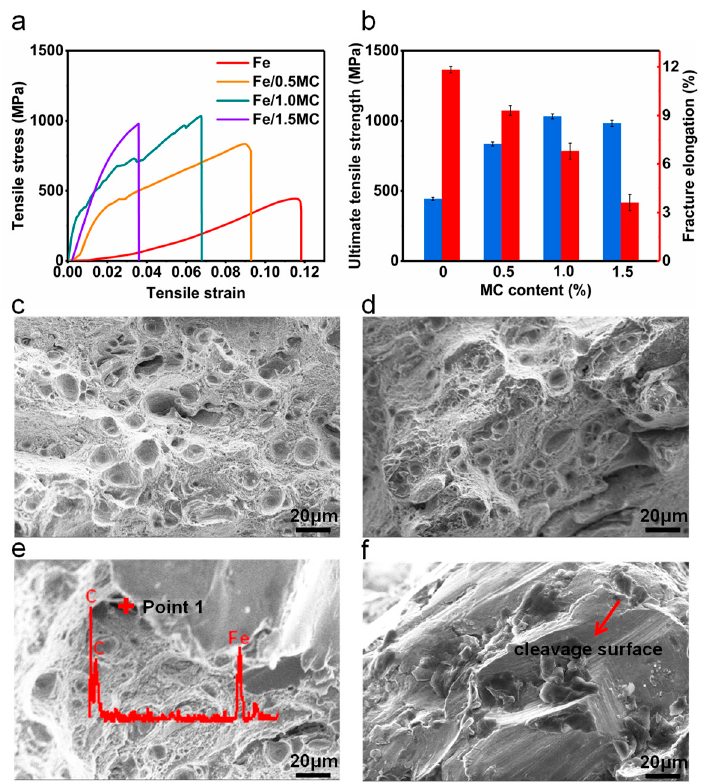
Figure 4. ( a ) Representative stress–strain curves obtained from tensile tests; ( b ) The calculated tensile strength and elongation from the stress–strain curves. n = 3. Fracture surface morphologies of as-built ( 4 ) Fe, ( d ) Fe/0.5MC, ( e ) Fe/1.0MC and ( f ) Fe/1.5MC.